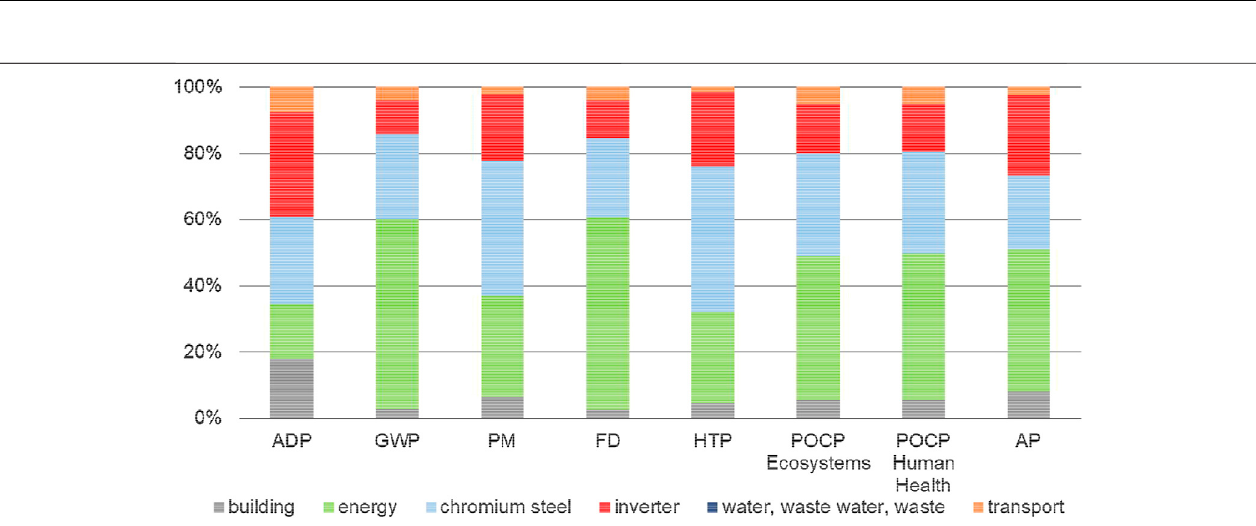
FIGURE 7 | Share of materials and energy demand on the total environmental impacts of the BoP construction for HT-co-electrolysis.